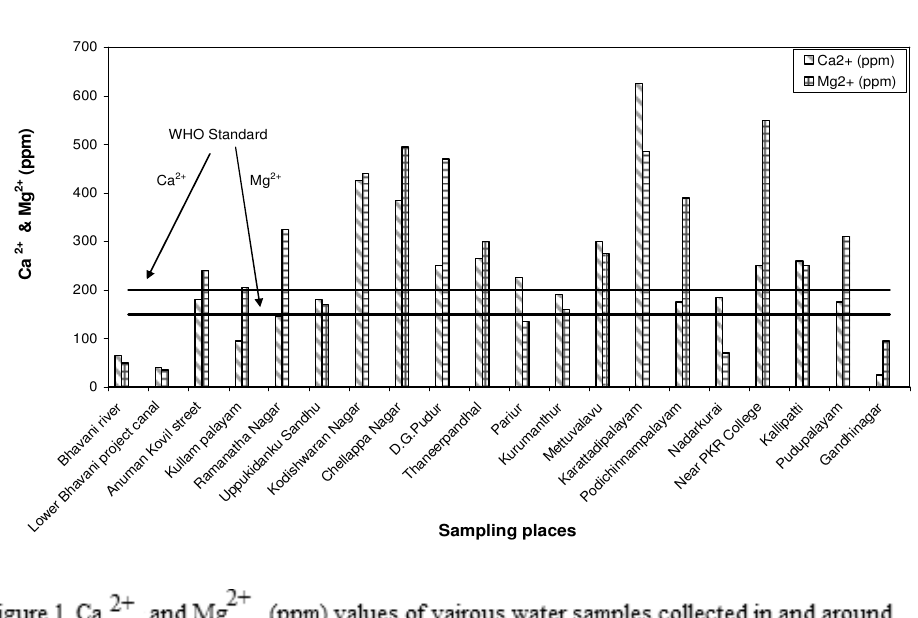
Fig.1. Ca 2+ & Mg 2+ (ppm) Values of Various Water Samples Colleceted in and